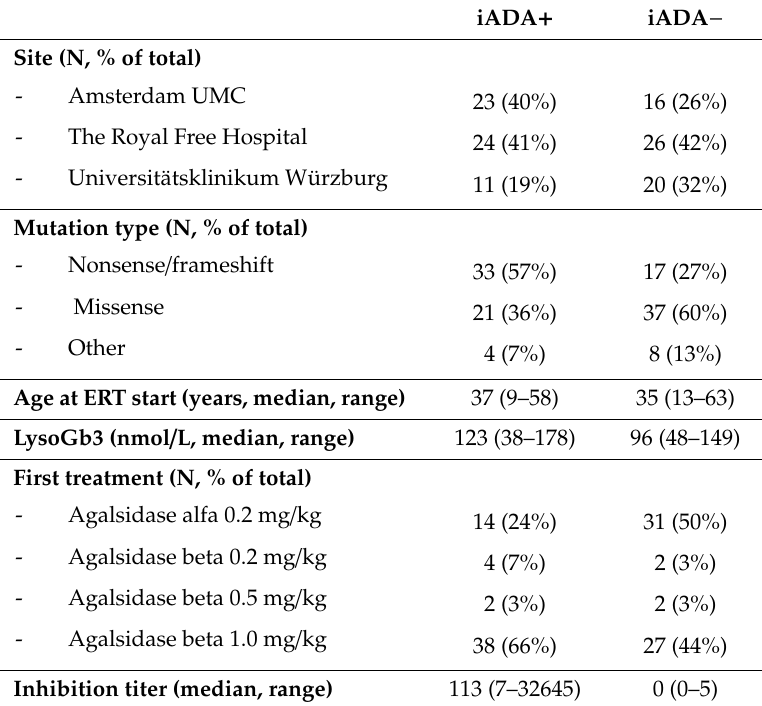
Table 1. Characteristics of 120 male patients with classic Fabry